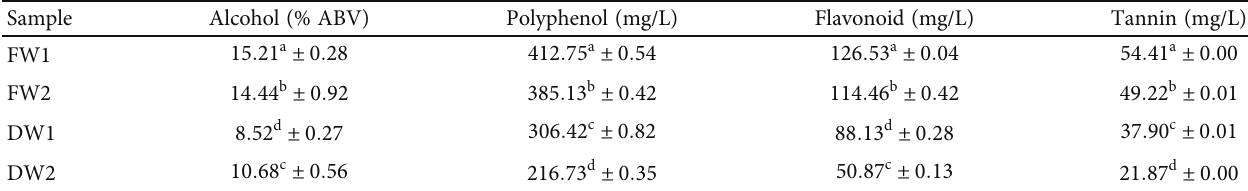
Table 2: Variations in alcohol, polyphenol, fl avonoid, and tannin content of wine samples.